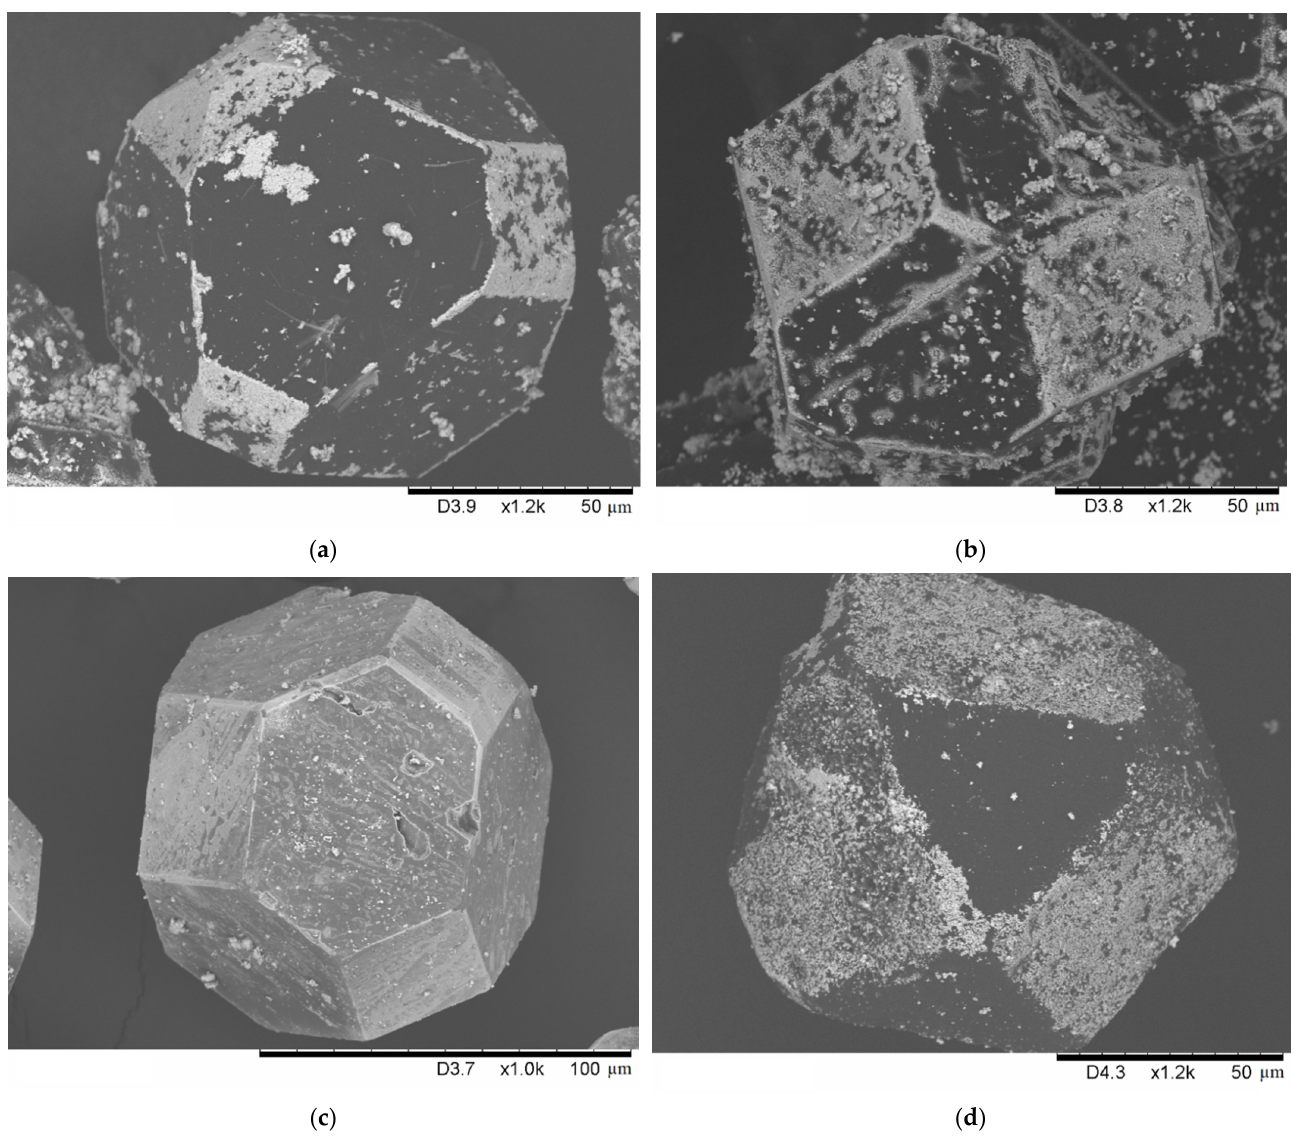
Figure 8. Surface of the diamond crystals: 10-1000-15-HP ( a ), 10-1000-30-HP ( b ),10-1000-15-SPS ( c ), and 50-1000-15-HP ( d ).